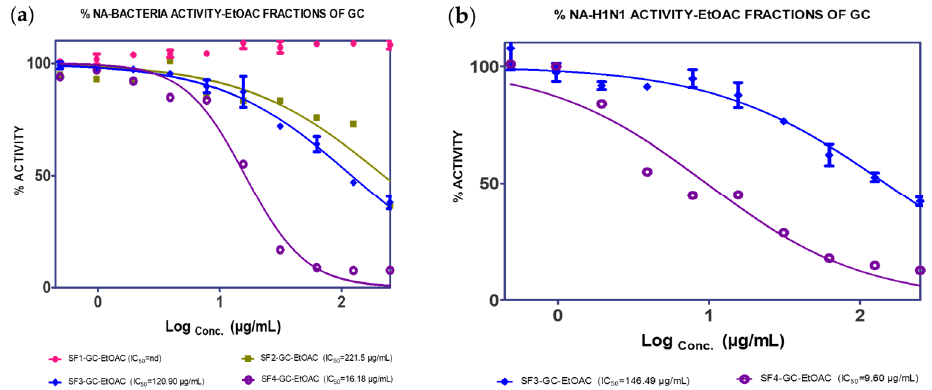
Figure 4. Neuraminidase inhibition activity of EtOAc fractions of GCL against ( a ) C. perfringens –NA and ( b ) H 1 N 1 -NA.